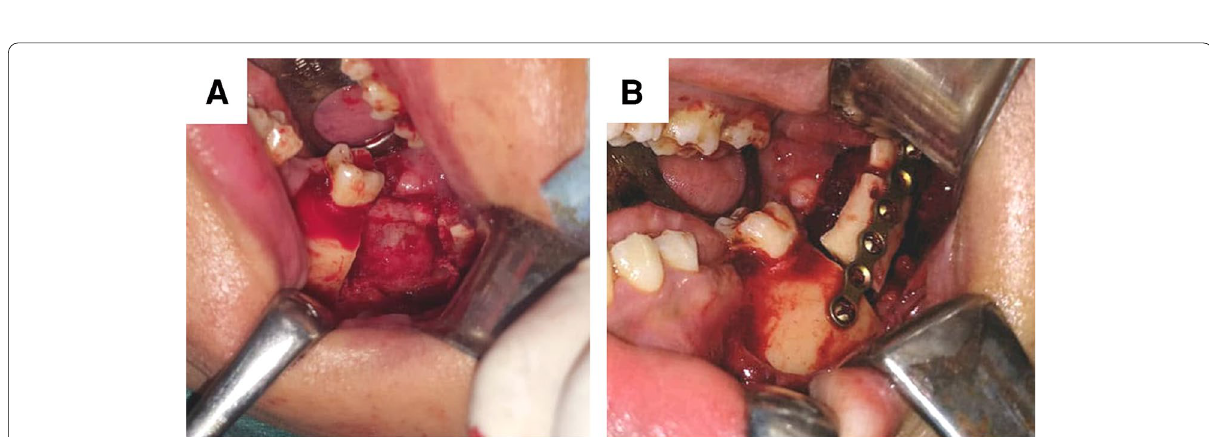
Fig. 5 Surgical procedures. A The lesion bed after the calcified mass removal. B Buccal cortical plate placed and fixed in